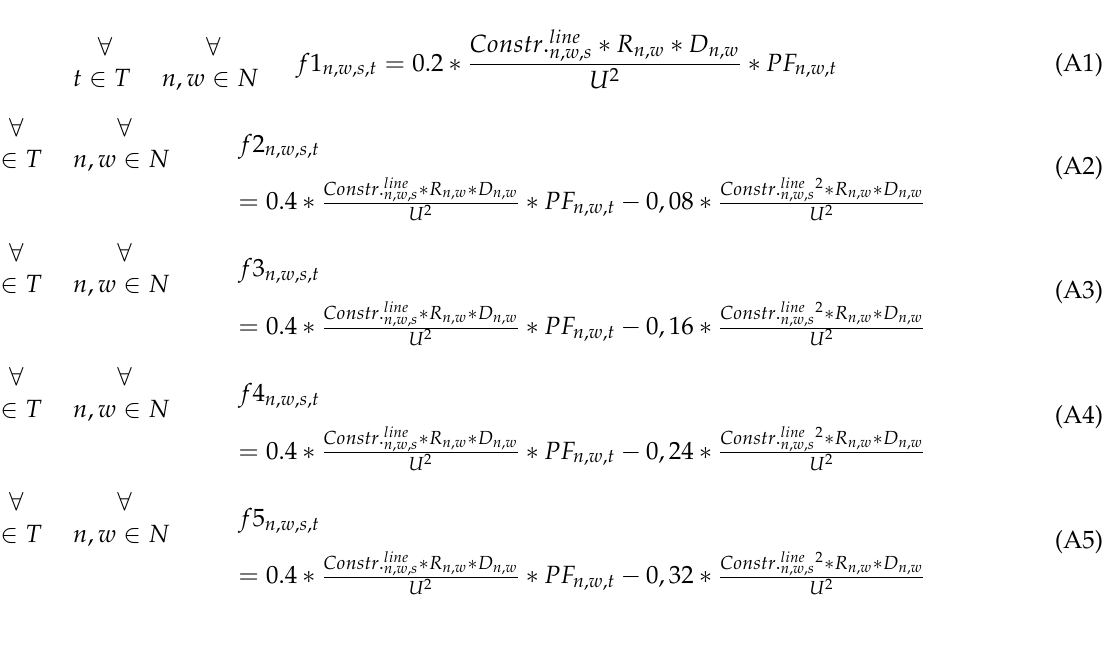
Figure A9. New lines for scenario “5”. Equations corresponding to Equation (9) that describe power losses in lines.